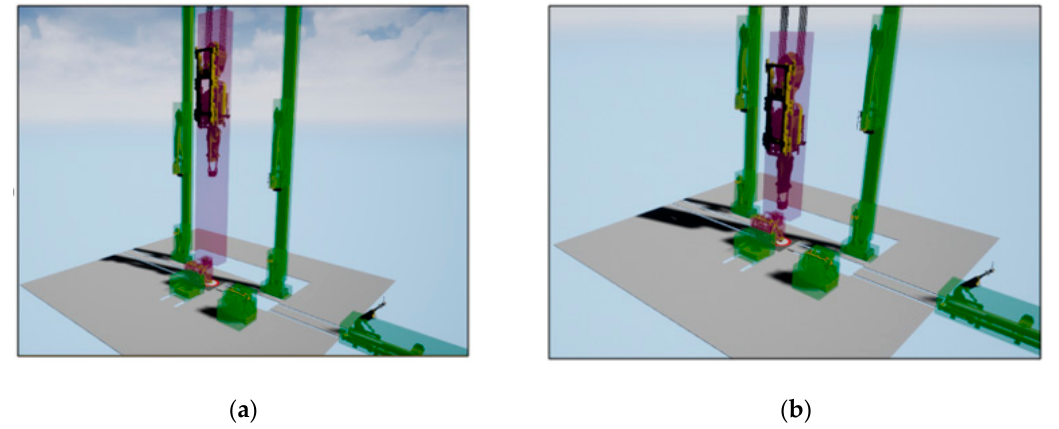
Figure 11. Results of the simulation in 2 cases of Scenario 1: ( a ) Kinematic Collision Box Algorithm ( b ) Original Collision Box.